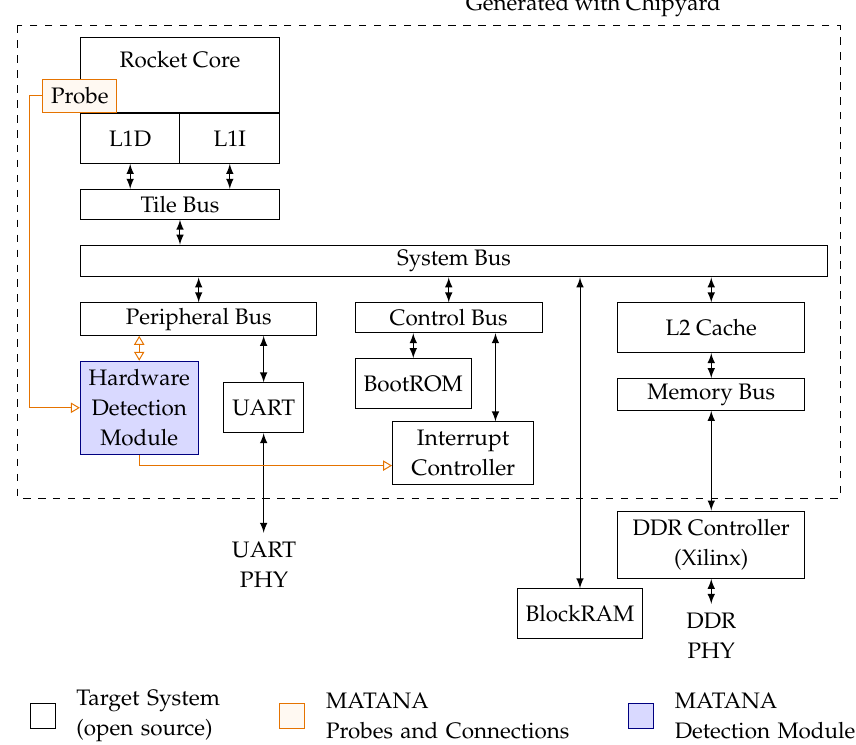
Figure 5. Hardware architecture of MATANA prototype implemented on